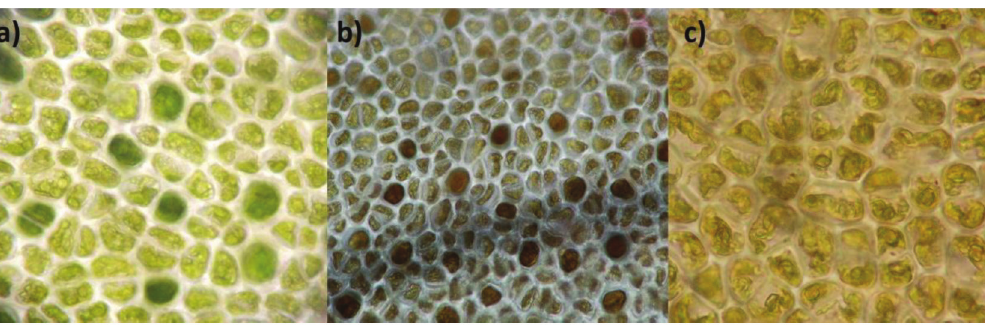
Fig. 5 – microscopic images of a) macroalgal biomass, b) acid pre-treated macroalgae, and c) alkaline pre-treated